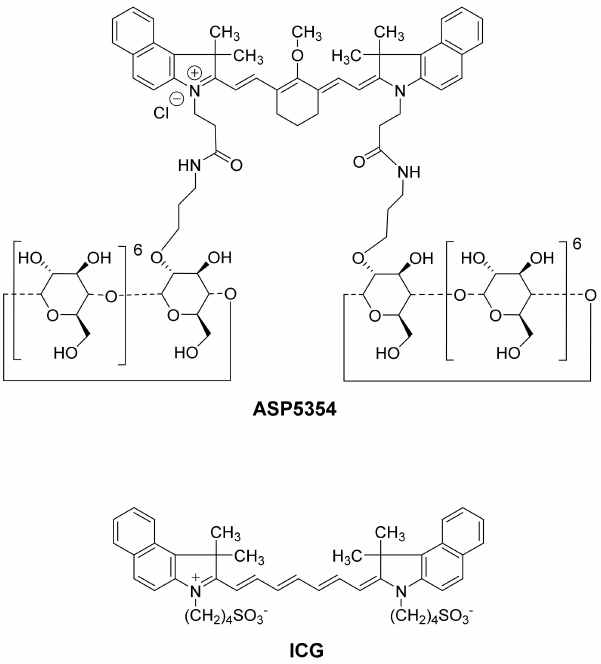
Figure 1. Chemical structures of ASP5354 and indocyanine green